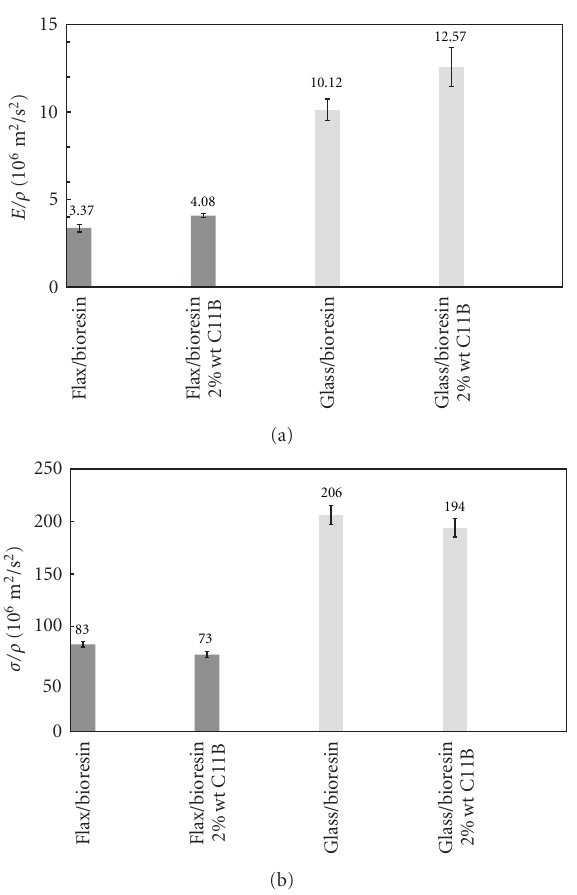
Figure 11: Mechanical properties of glass and flax reinforced nanoclays composite made by SCRIMP process: (a) specific flexural modulus (b) specific ultimate strength.